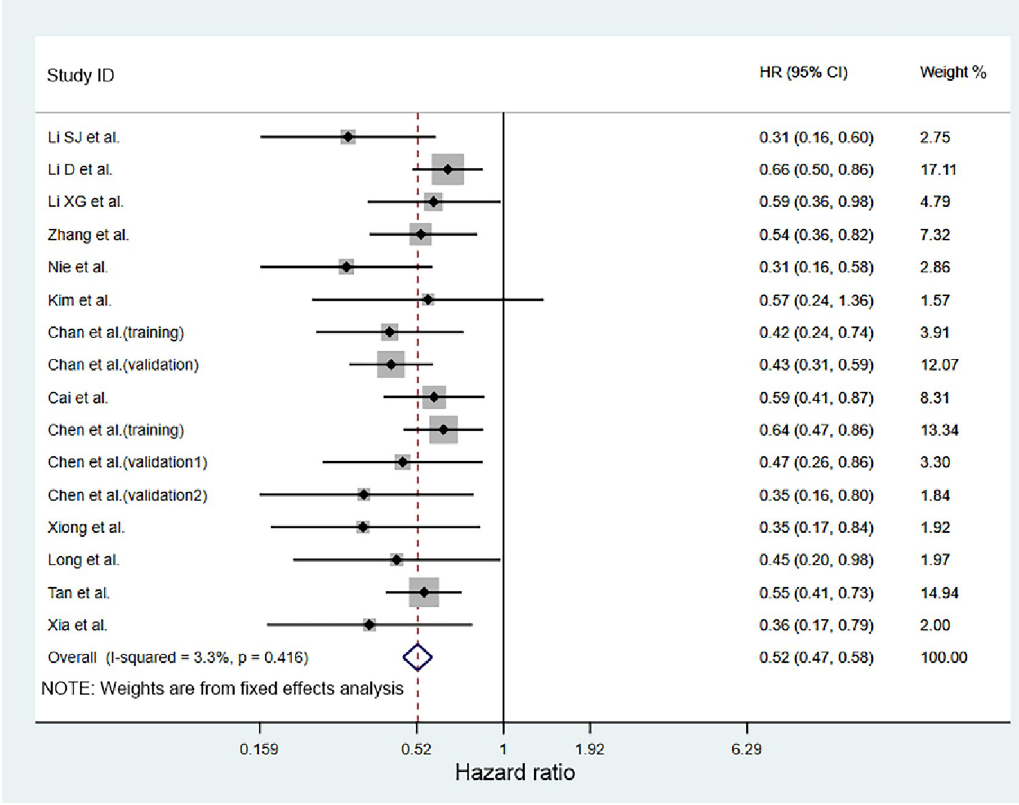
Fig 2. Forest plot of hazard ratio for OS in cancer patients.